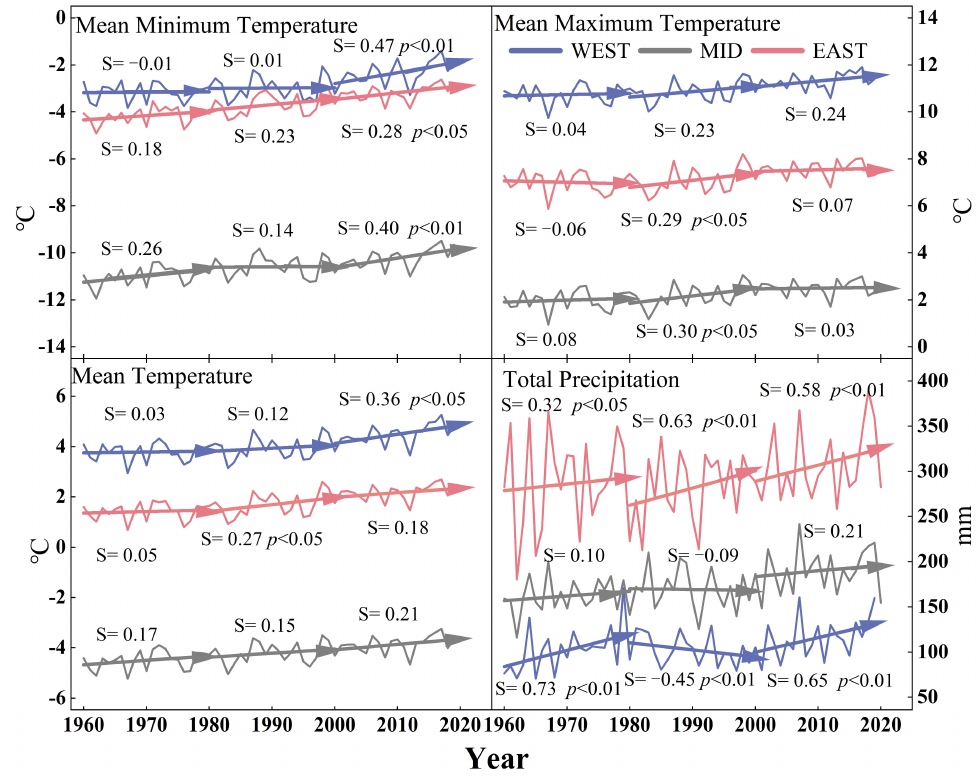
Figure 3. Interannual variability of the mean maximum temperature, mean temperature, mean minimum temperature, and total precipitation from 1960 to 2020 in three regions of the Qilian Mountains from east to west (s—slope; solid line with arrows—linear regression).